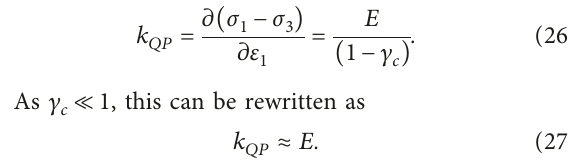
Figure 4: Characteristics of stress-strain curve at compaction stage σ 3 0 . σ 2 (cid:31) ) ( >